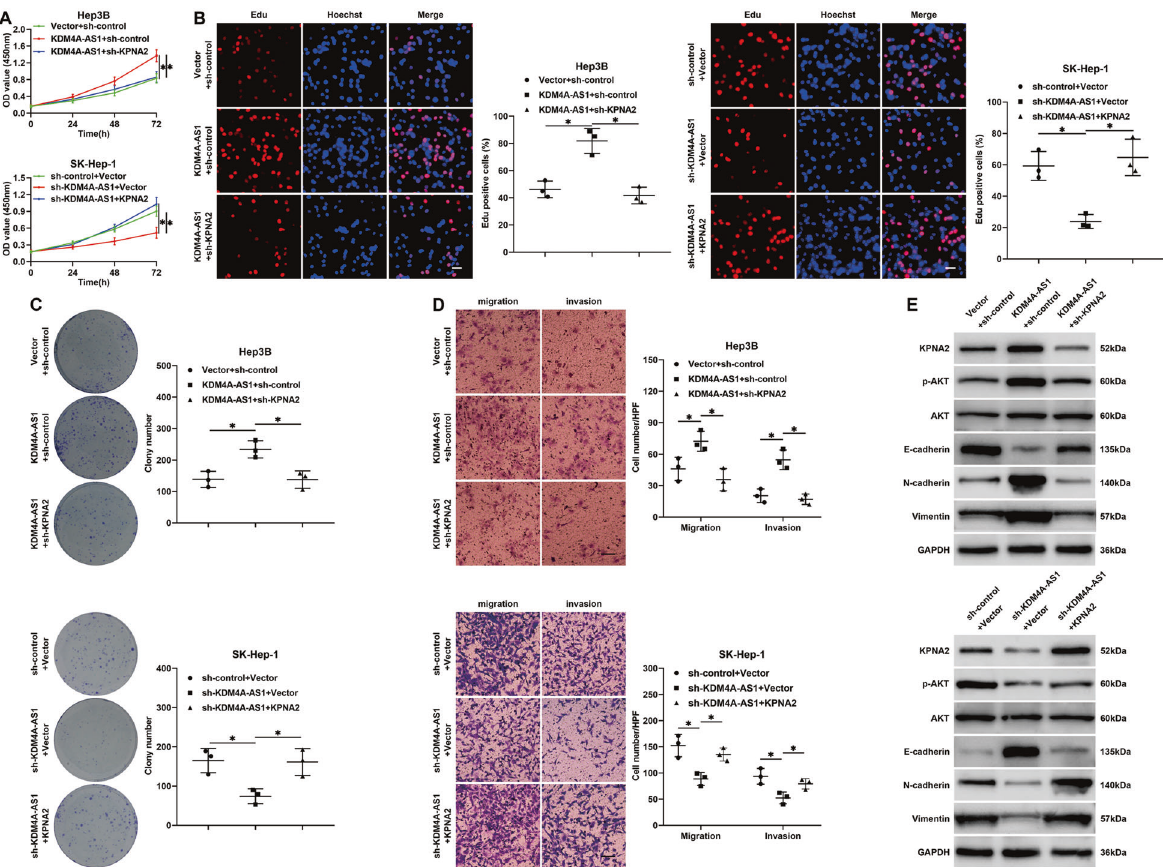
Fig. 7 KPNA2 mediates the function of KDM4A-AS1 in HCC cells. Hep3B cells with KDM4A-AS1 overexpression were transfected with KPNA2 shRNA (sh-KPNA2) or nontargeting shRNA (sh-control), while SK-Hep-1 cells with KDM4A-AS1 knockdown were transfected with a vector carrying KPNA2 cDNA or empty vector. A CCK-8, B Edu, C colony formation, and D transwell assays were performed to evaluate the proliferation, migration, and invasion of HCC cells in different groups. E Western blotting was conducted to measure the levels of KPNA2, p-AKT, AKT, E-cadherin, N-cadherin, and Vimentin in HCC cells. Scale bar: 20 μ m for Edu results and 100 μ m for transwell results. All the data are presented as mean ± SD of at least three independent experiments. * P <